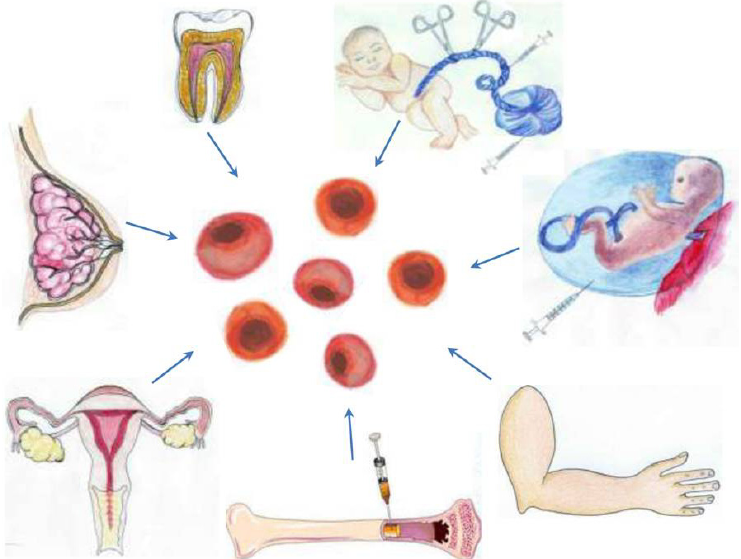
Figure 1. Adult stem sources include umbilical cord blood, placenta, amniotic fluid, bone marrow, menstrual blood, breast milk, dental pup, and skin fibroblasts. Most of these cells have been shown to exert neuroprotective effects in stroke animal models and a few have reached clinical trials in stroke